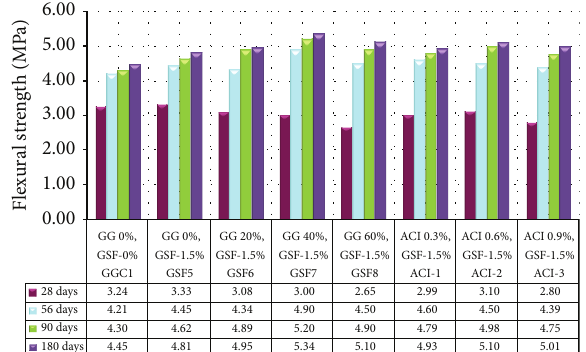
Figure 12: Flexural strength of concrete specimens cured in sodium chloridesolutionforvariousconcretemixes(subjectedto40%initial stress).